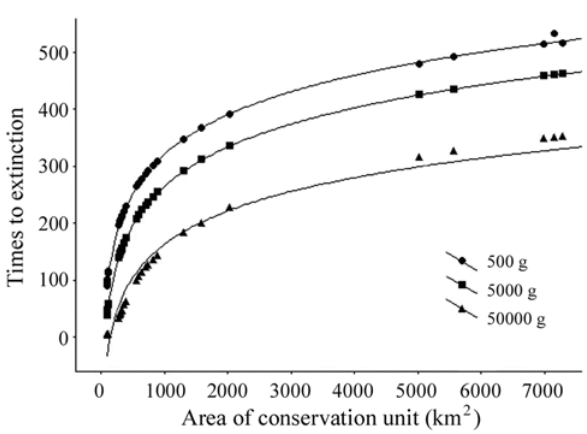
Figure 2 - Relationship between average times to extinction (years) and area of the 31 conservation units, for the three body-size